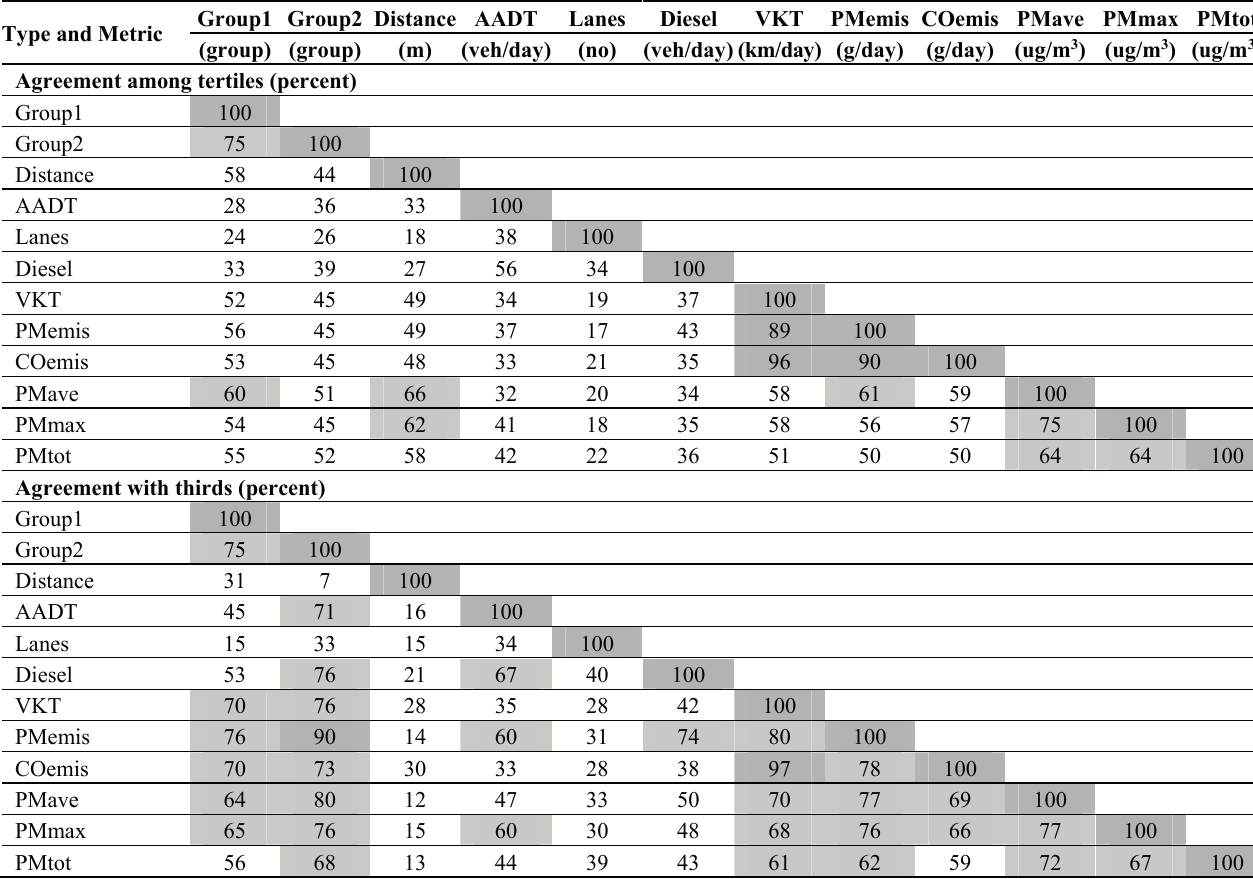
Table 4. Comparison of exposure metrics at the NEXUS homes showing concordance with classifications using tertiles and “thirds”. Shaded numbers show percentage agreement above 60 and 80%. Variables and sample size are defined in Table